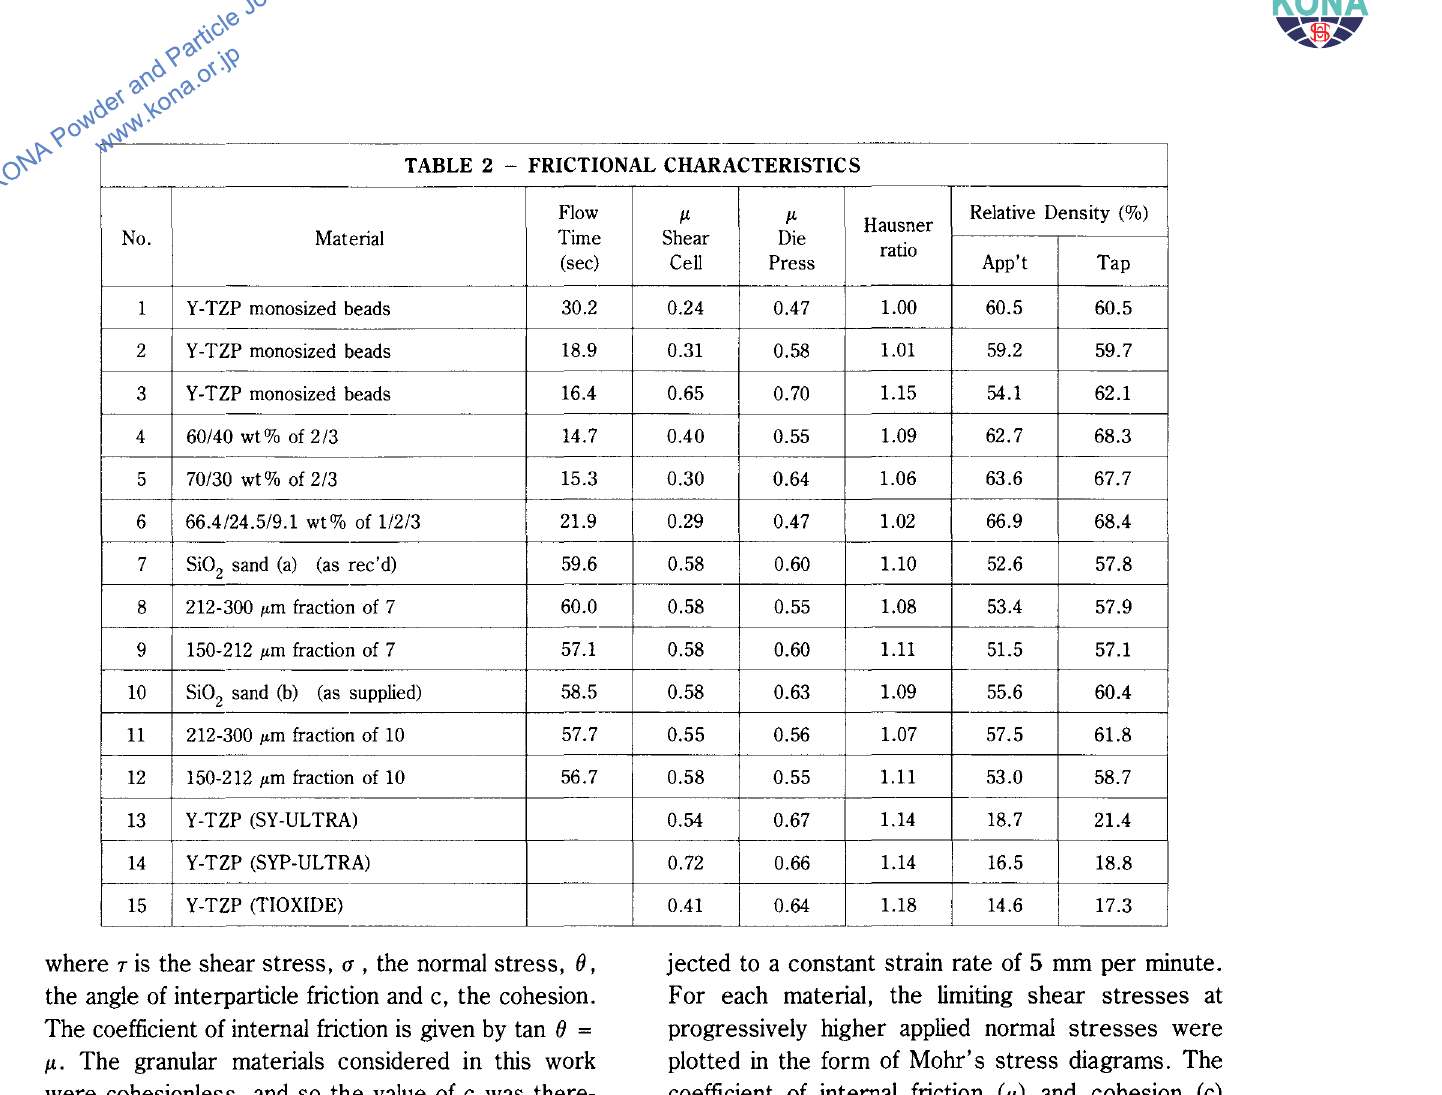
TABLE 2 - FRICTIONAL CHARACTERISTICS